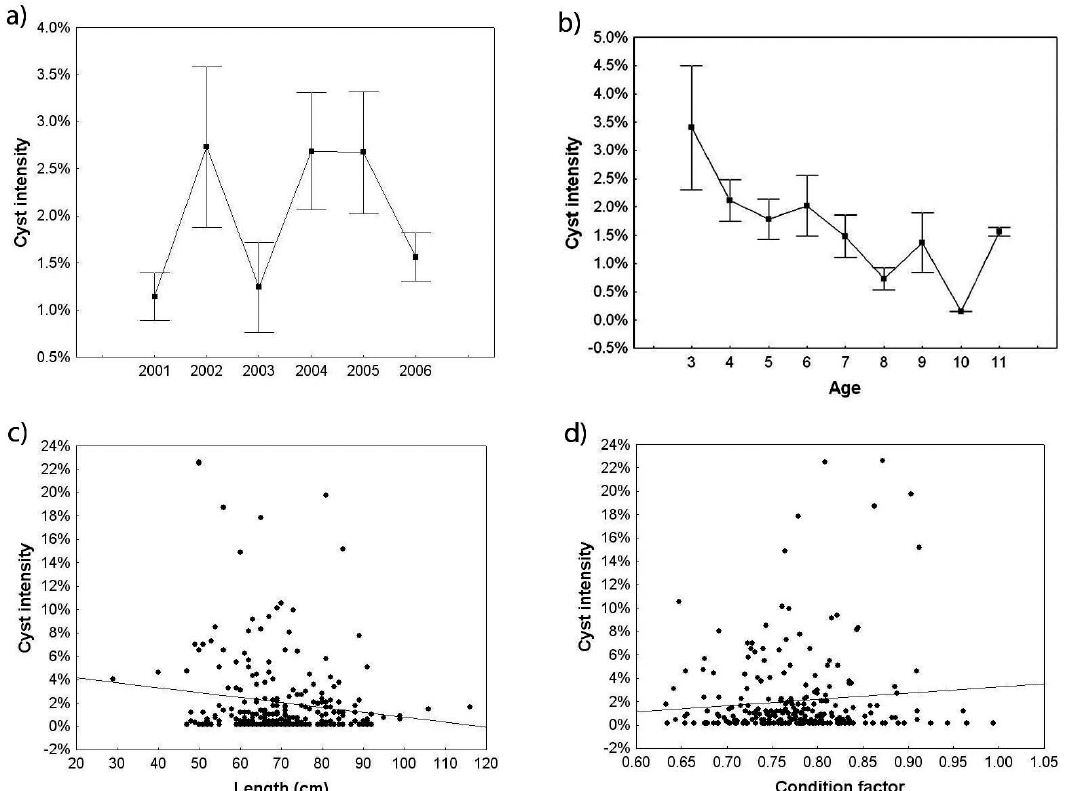
Fig. 7. – For Atlantic cod: a) annual mean ± standard error of cyst intensity; b) mean ± standard error of cyst intensity by age; c) linear relation- ship between cyst intensity and female length (y=0.05-0.0004x); and d) linear relationship between cyst intensity and female condition factor